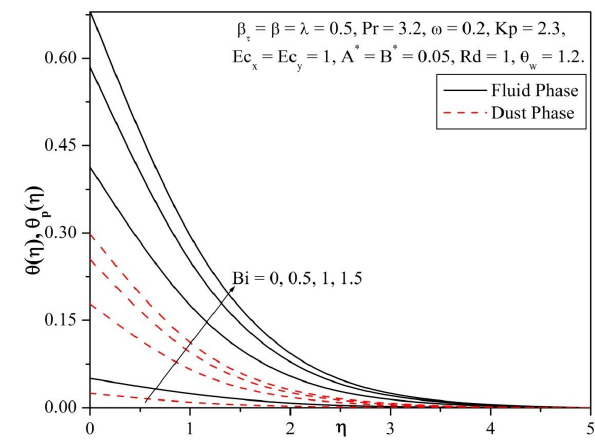
Fig. 16: Dimensionless temperature profiles for different values of B i .